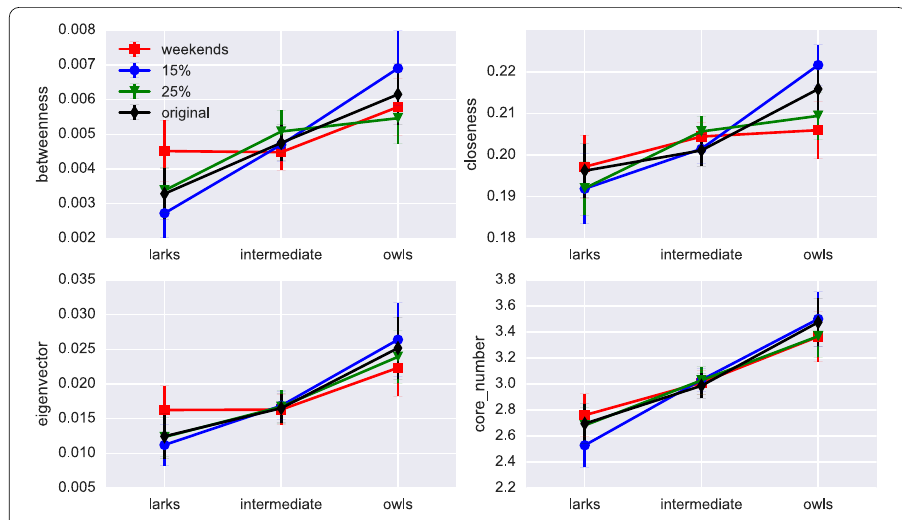
Figure 5 Robustness of centrality measures. We tested whether the centrality results are robust against variations in the analysis pipeline. The four measures are shown above, for the original chronotypes (black diamonds), for chronotypes computed using weekend data only (red squares), and for chronotypes with smaller shares of owls/larks (15%, blue circles) and larger (25%, green